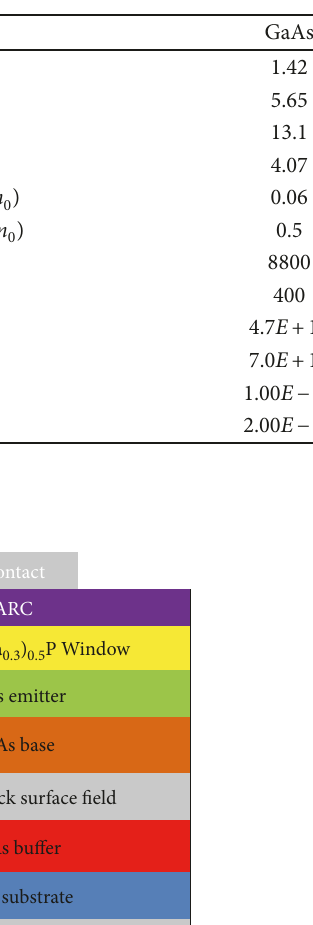
Table 1: Standard parameters used in this solar cell design.